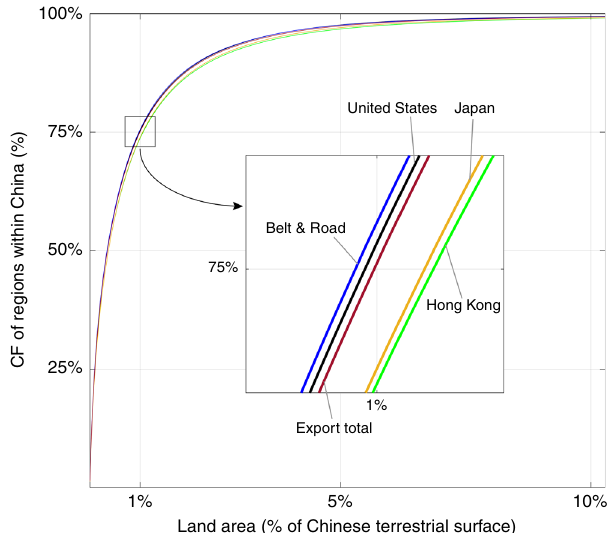
Fig. 2 Spatial spread of CF of selected regions in China in 2012. It shows the minimum fraction of the Chinese land area required to hold the CFs of regions. The horizontal axis represents the shares of the land area of the Chinese terrestrial surface, and the vertical axis represents the proportions of CF within China.